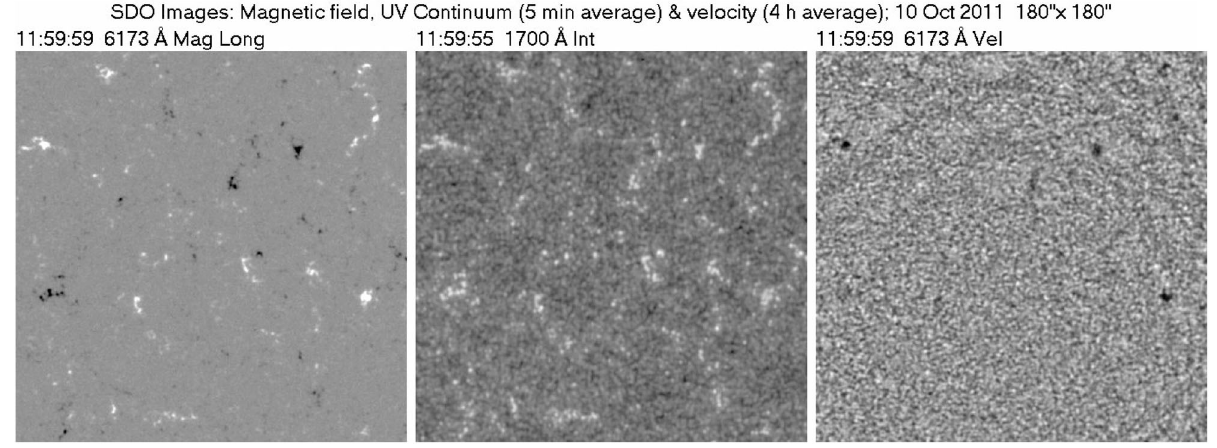
Frontiers in Astronomy and Space Sciences |